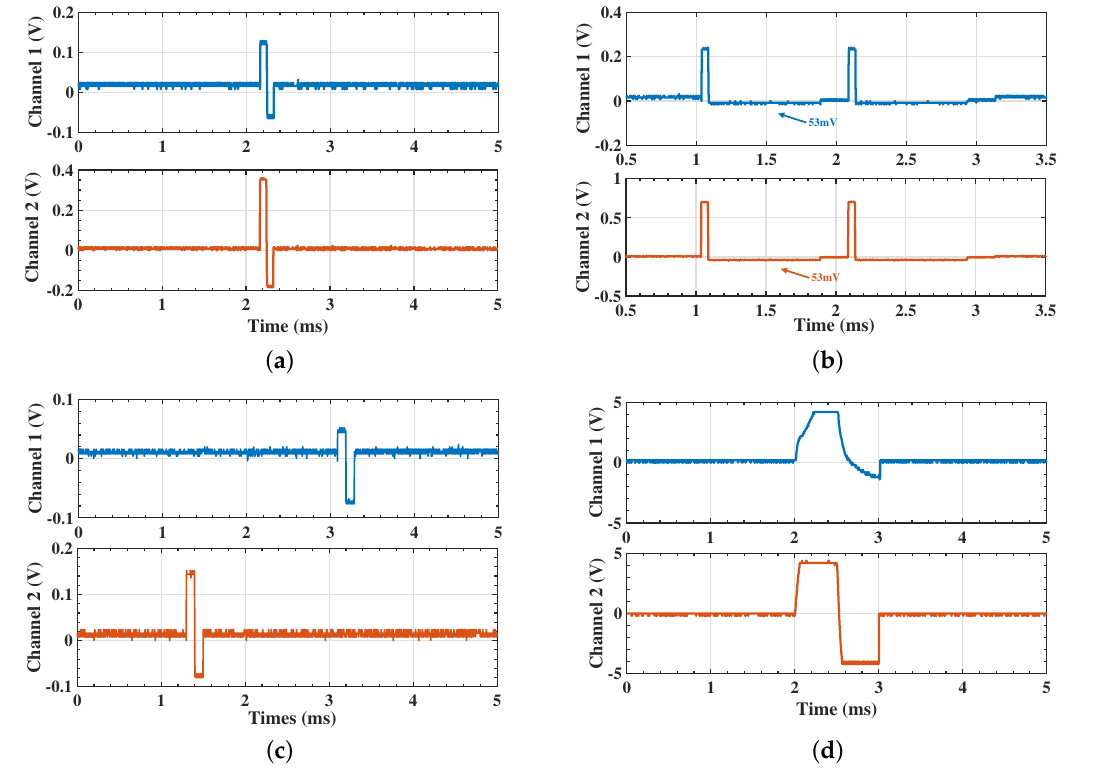
Figure 12. ( a ) The measured output voltage with a 5 k Ω load; ( b ) the measured independent output voltage under asymmetrical output mode from two different pairs of electrodes with different loads of 1 k Ω and 2 k Ω , respectively; ( c ) the measured output voltage; the stimulation current is programmed by the SPI; ( d ) in vitro experimental results. (Upper waveform) Output voltage over a pair of electrodes immersed in saline (lower waveform). Output voltage with tungsten electrode